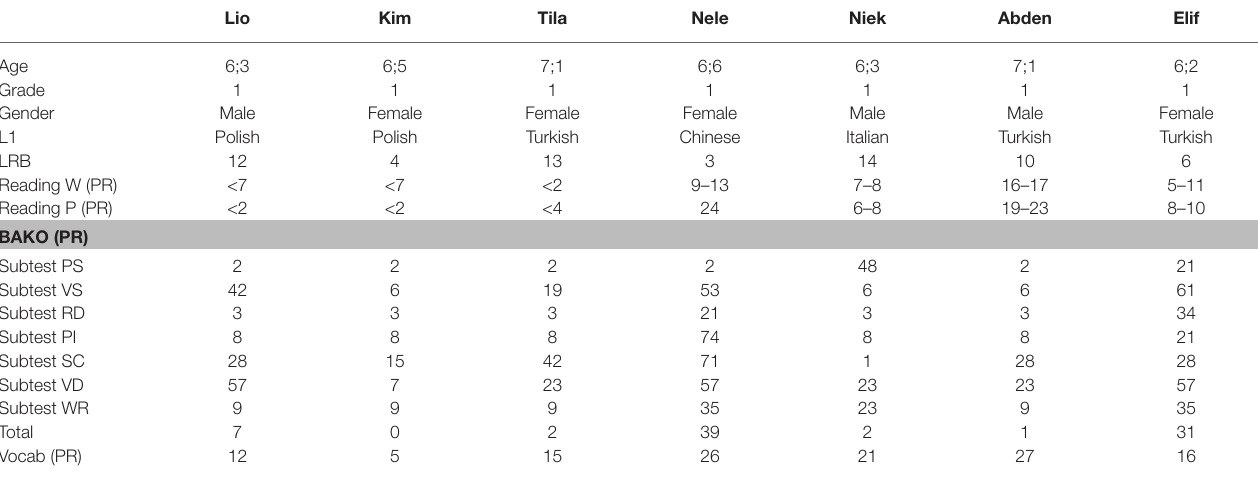
TABLE 1 | Characteristics of the